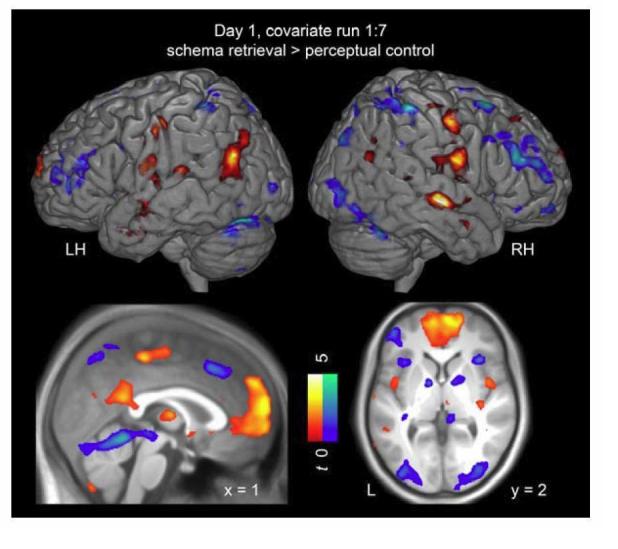
Changes in activation as a function of run on day 1.Increases in activation are shown in warm colors, decreases in cool colors. For display purposes, all maps were resliced to a voxel dimension of 0.5 mm isotropic and are shown at P < 0.001, uncorrected. Significant clusters are noted in Author response table 1. LH – left hemisphere; RH – right hemisphere; L – left.